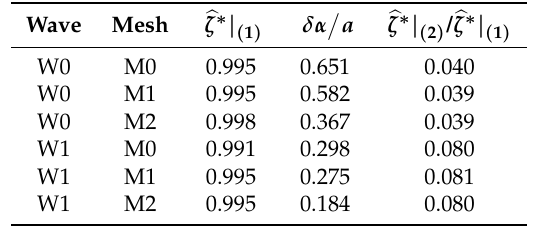
Table 6. Wave propagation tests in a two-dimensional NWT . Results are for the RANS simulations. Euler results are within 0.0001 a of the RANS results for all cases studied. ± wave amplitude, δα / a is the non-dimensional interface spread between the iso-lines of α = 0.95 and α = 0.05.